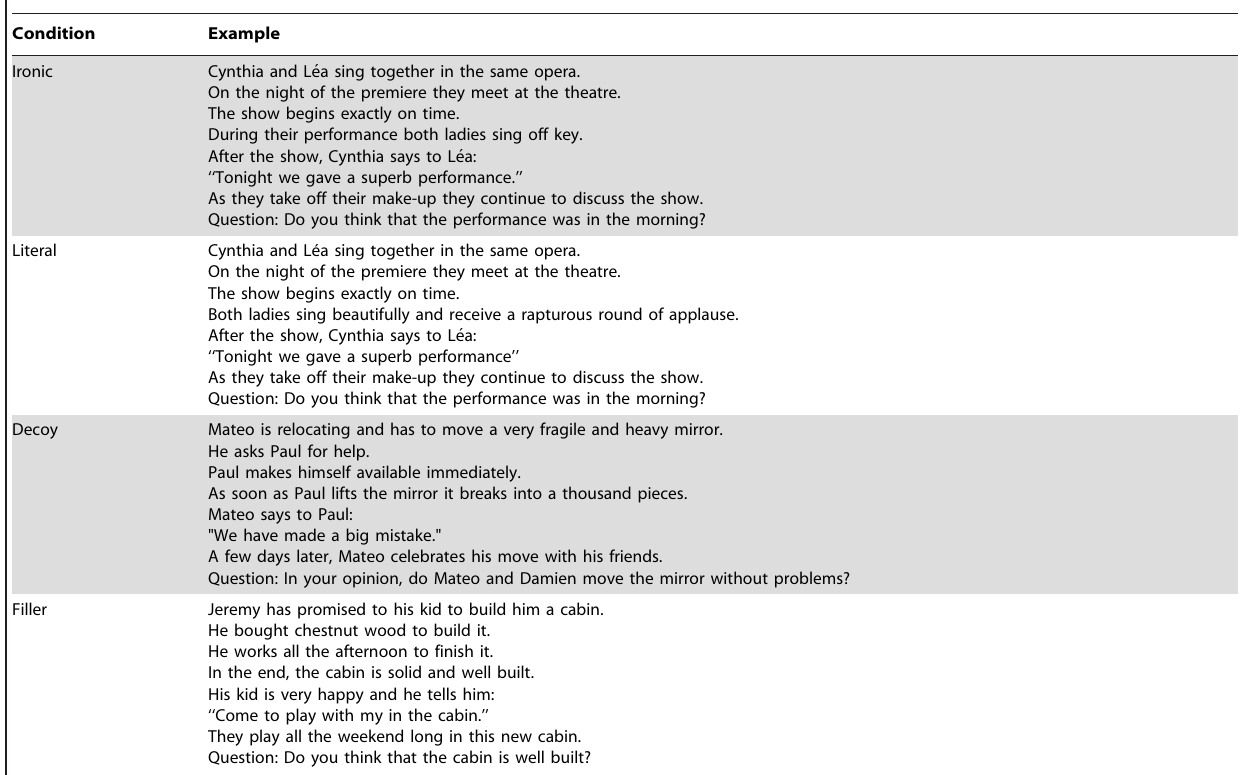
Condition Example